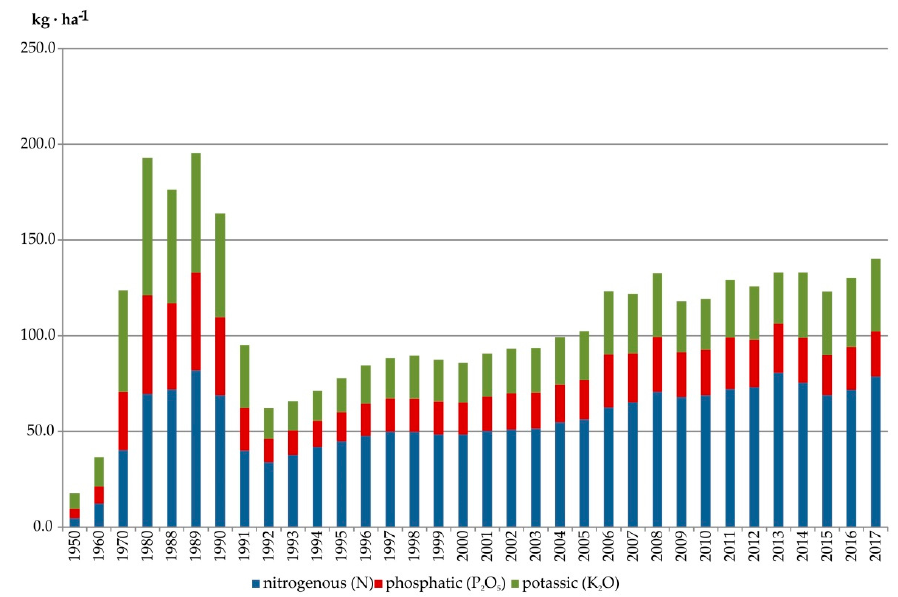
Figure 3. Amount of fertiliser (kg) per hectare in Poland.